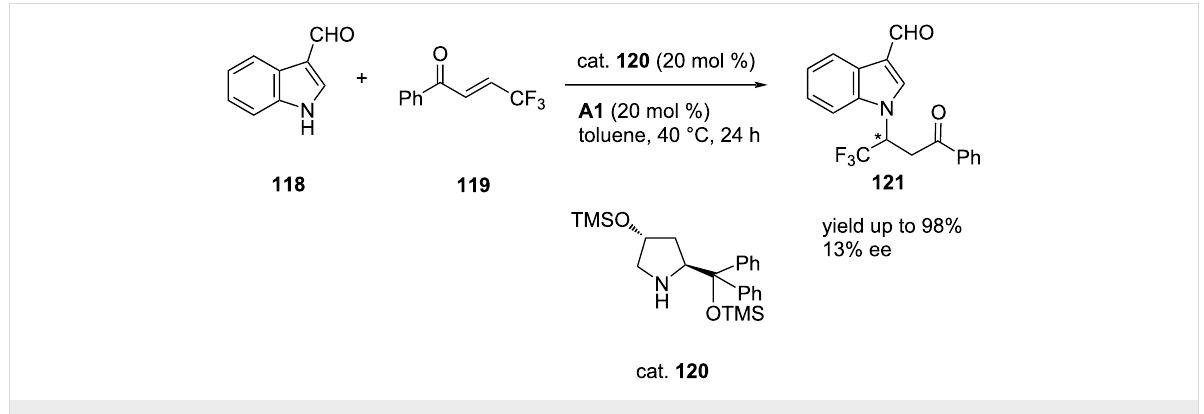
groups, benzenesulfonyl moieties with electron-donating